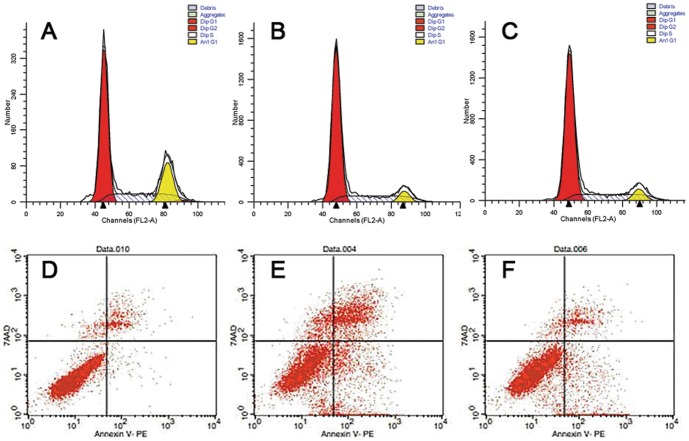
Flow cytometric analyses of the effect of ASO-miR-129-5p on Hep-2 cells' cell cycle and apoptosis.(A) Cell cycle profile of the untreated group; G0/G1 = (70.39±1.34%), G2/M = (1.53±0.53%), S = (28.09±1.33%). (B) Cell cycle profile of the ASO-miR-129-5p group; G0/G1 = (77.31±2.31%), G2/M = (1.73±1.05%), S = (20.97±1.53%). (C) Cell cycle profile of the GFP control group; G0/G1 = (71.03±1.21%), G2/M = (1.54±0.82%), S = (27.44±0.98%). One representative experiment of the 6 independent experiments is shown. (D) The percentage of apoptotic cells in the untreated group (1.87±1.44%). (E) The percentage of apoptotic cells in the ASO-miR-129-5p group (13.61±1.12%). (F) The percentage of apoptotic cells in the GFP control group (5.98±1.23%). One representative experiment of the 3 independent experiments is shown.